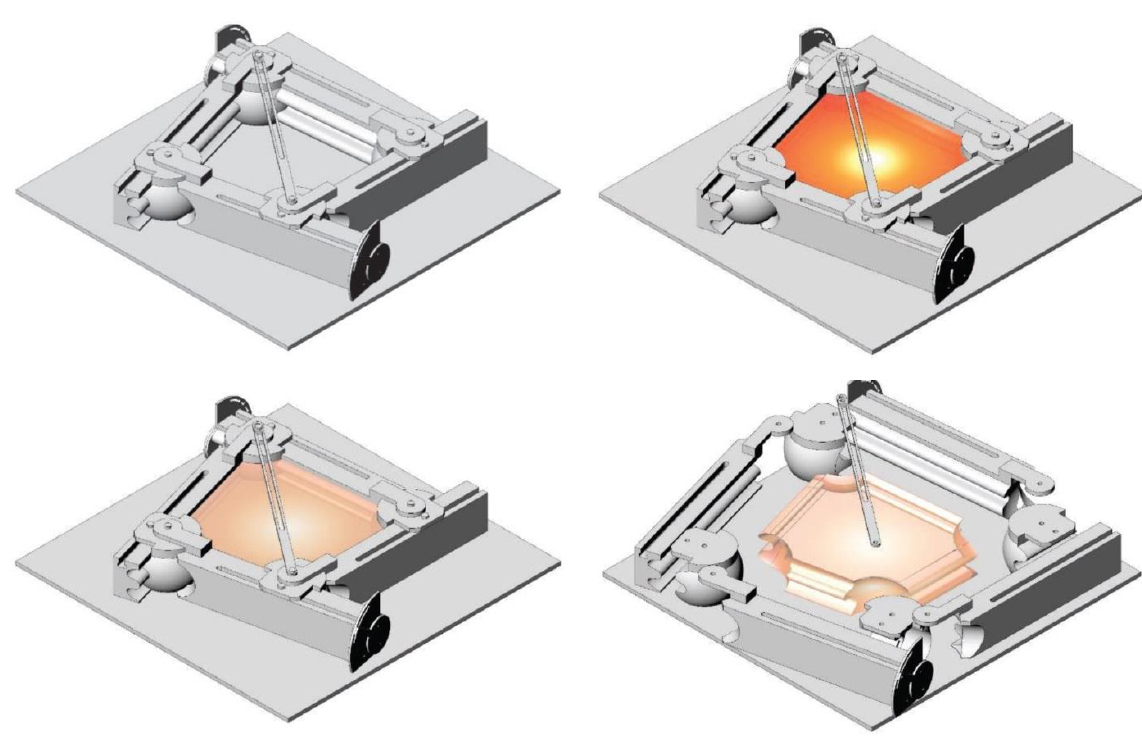
Fig. 19 Proposed casting process using the designed adjustable mould: The mould is set to the desired dimensions by tightening the bolts on the T-slots and diagonals (top left) and is preheated to avoid surface chills. Hot glass is poured to the mould (top right) and is left to rapidly cool down until the glass is slightly above its annealing point (bottom left). At this stage, the glass object is able to sustain its shape and the mould can be removed by releashing the bolts and hinge pins (bottom right). Then the glass object can be placed into the annealing oven to be controllably cooled